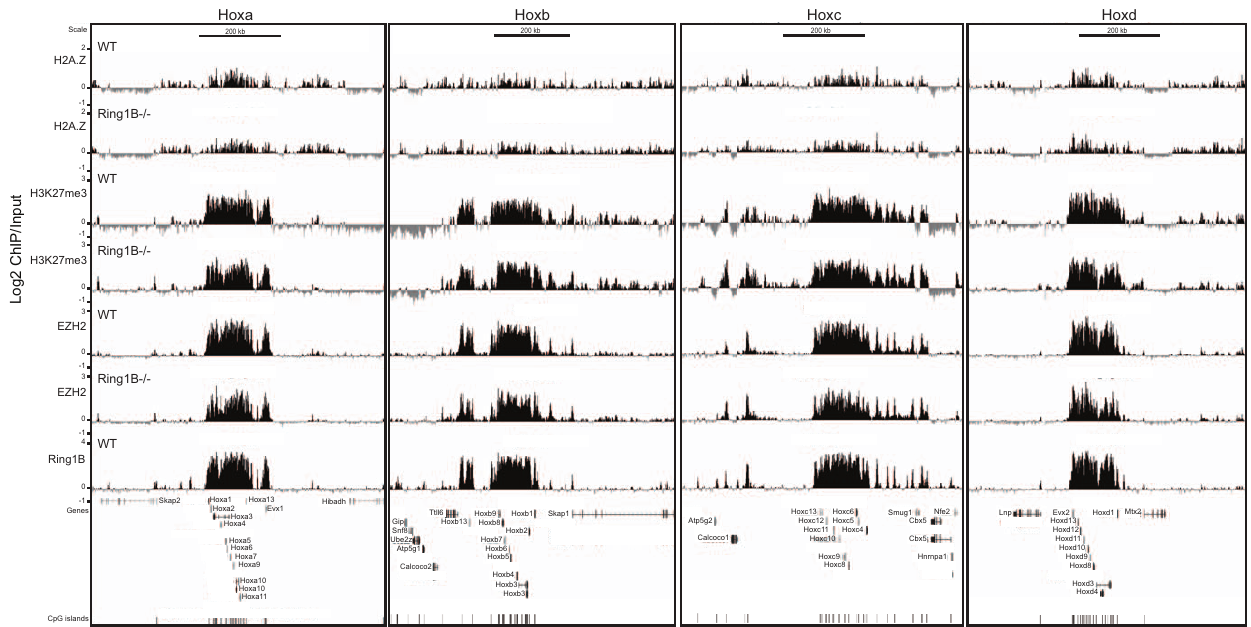
Figure 3. H2A.Z maps to Hox loci in wild-type and PRC1 mutant ESCs. Log2 of ChIP:input for: H2A.Z, H3K27me3, EZH2 and Ring1B from WT ( + / + ) (top) and Ring1B 2 / 2 (bottom) ESCs using a custom tiling microarray. Data is shown for the four paralogous murine hox loci (Hoxa, Hoxb, Hoxc and Hoxd) and their flanking genomic regions. The data represent a mean of 2 biological replicates. RefSeq gene annotations and CGIs are from the July 2007 (mm9) Build 37 assembly of the mouse genome